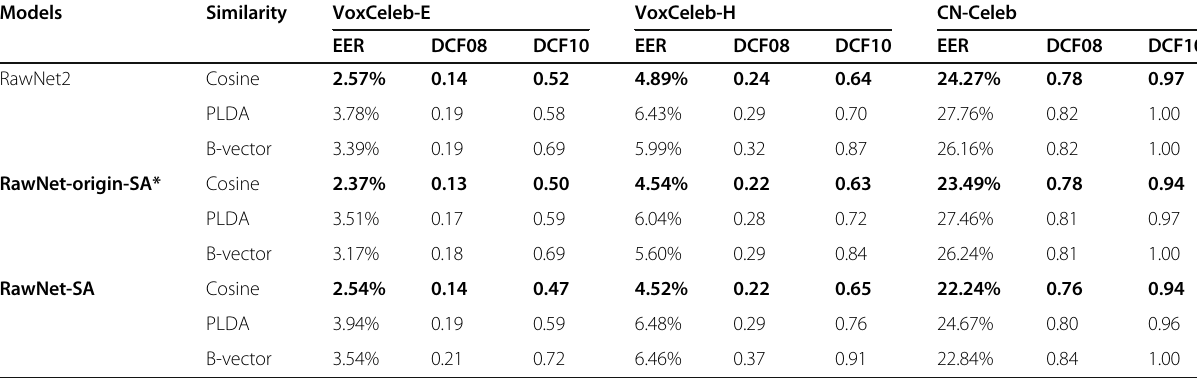
Table 9 The influence of different similarity measurements on the recognition performance Models RawNet2